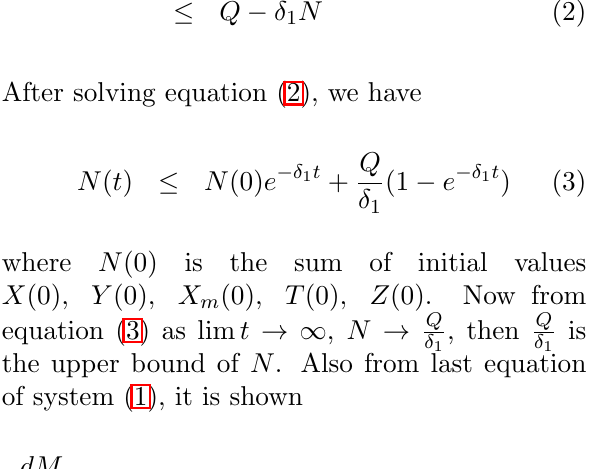
Table 2. Description of parameters of the model Parameters